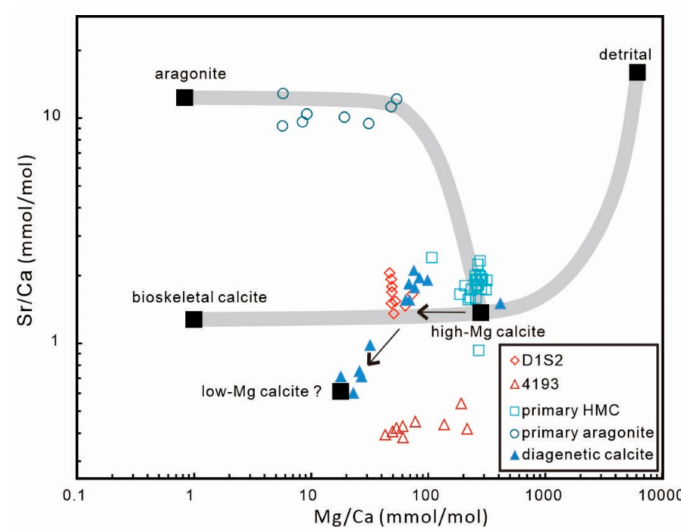
Figure 5. Plot of Sr / Ca vs. Mg / Ca ratios of the studied low-magnesium calcites, primary aragonite, primary high-magnesium calcite (HMC), and diagenetically altered calcite (diagenetic calcite; [6]). The endmembers (filled squares) and mineralogical trends of carbonate minerals are after Bayon et al. [49] and Joseph et al. [6]. Arrows represent the trend of HMC conversion to LMC [6]. Note that the ‘detrital’ represents the endmember of detrital fractions